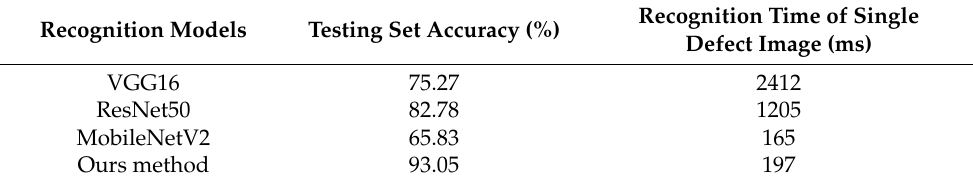
Figure 10. Error loss and accuracy of the recognition models: ( a , b ) VGG16, ( c , d ) MobileNetV2, ( e , f ) ResNet50, and ( g , h ) EfficientNet. Table 4. Comparison of results of different models on the testing set.